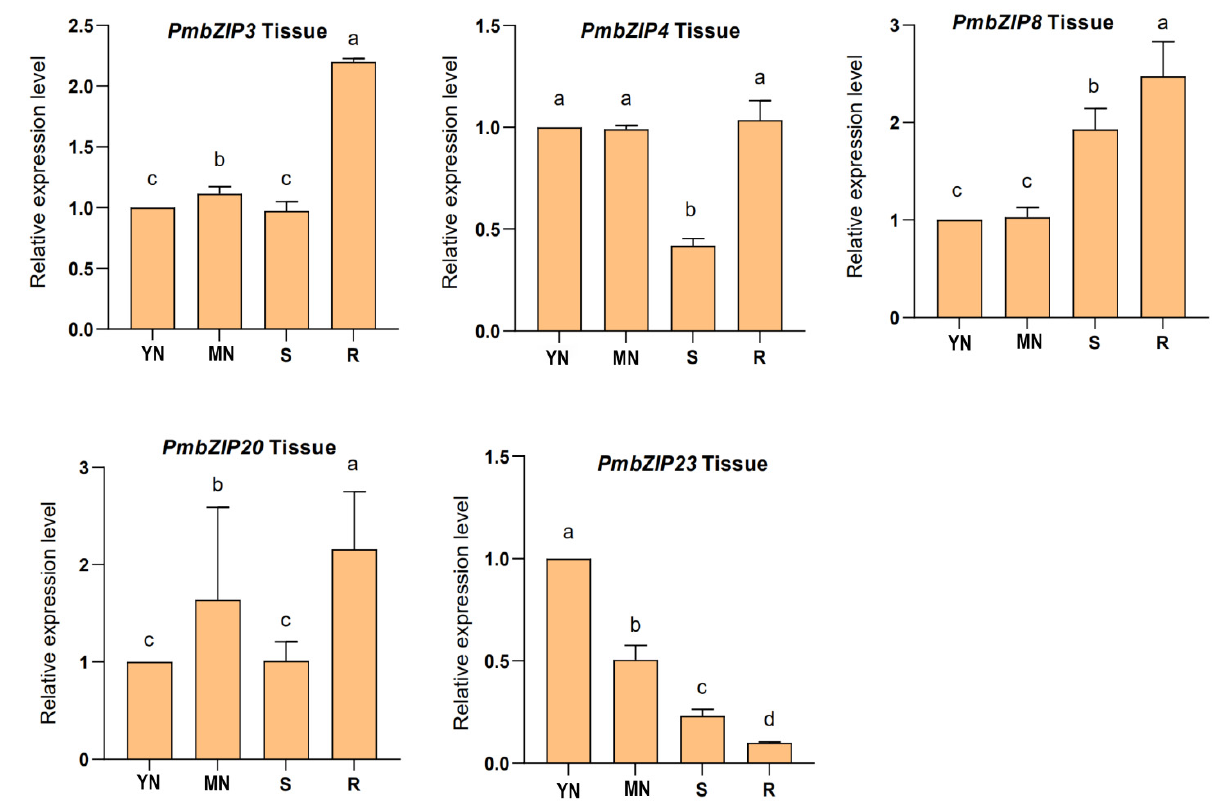
Figure 6. The expression levels of PmbZIPs in different tissues in P. massoniana . YN: young needles; MN: mature needles; S: stems; R: roots. The relative expression level is indicated as the mean ± standard deviation (SD). Different letters show significant differences at the 0.05 level with the Duncan method.